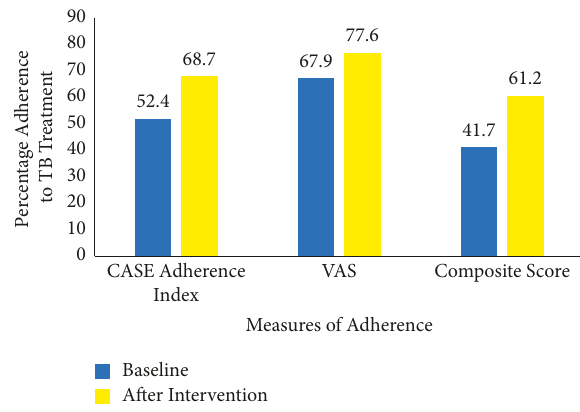
Figure 4: Level of adherence to DOTS TB participants as measured by VAS and CASE adherence index at Baseline and after the single- way and double-way SMS intervention. Key: VAS; Visual Analogue Scale, CASE: Center for Adherence Support